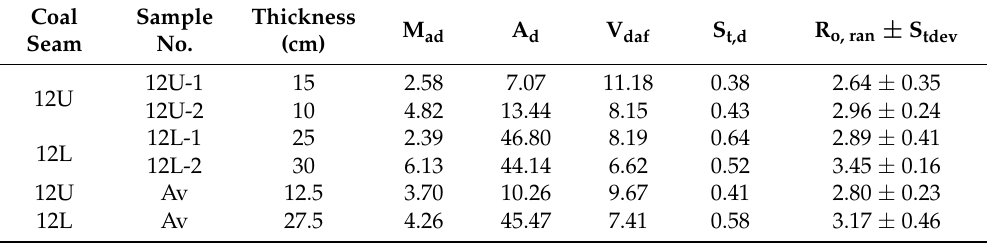
Table 1. Proximate analysis (%) and vitrinite reflectance (%) of coal benches in the Meitian Mine. Coal